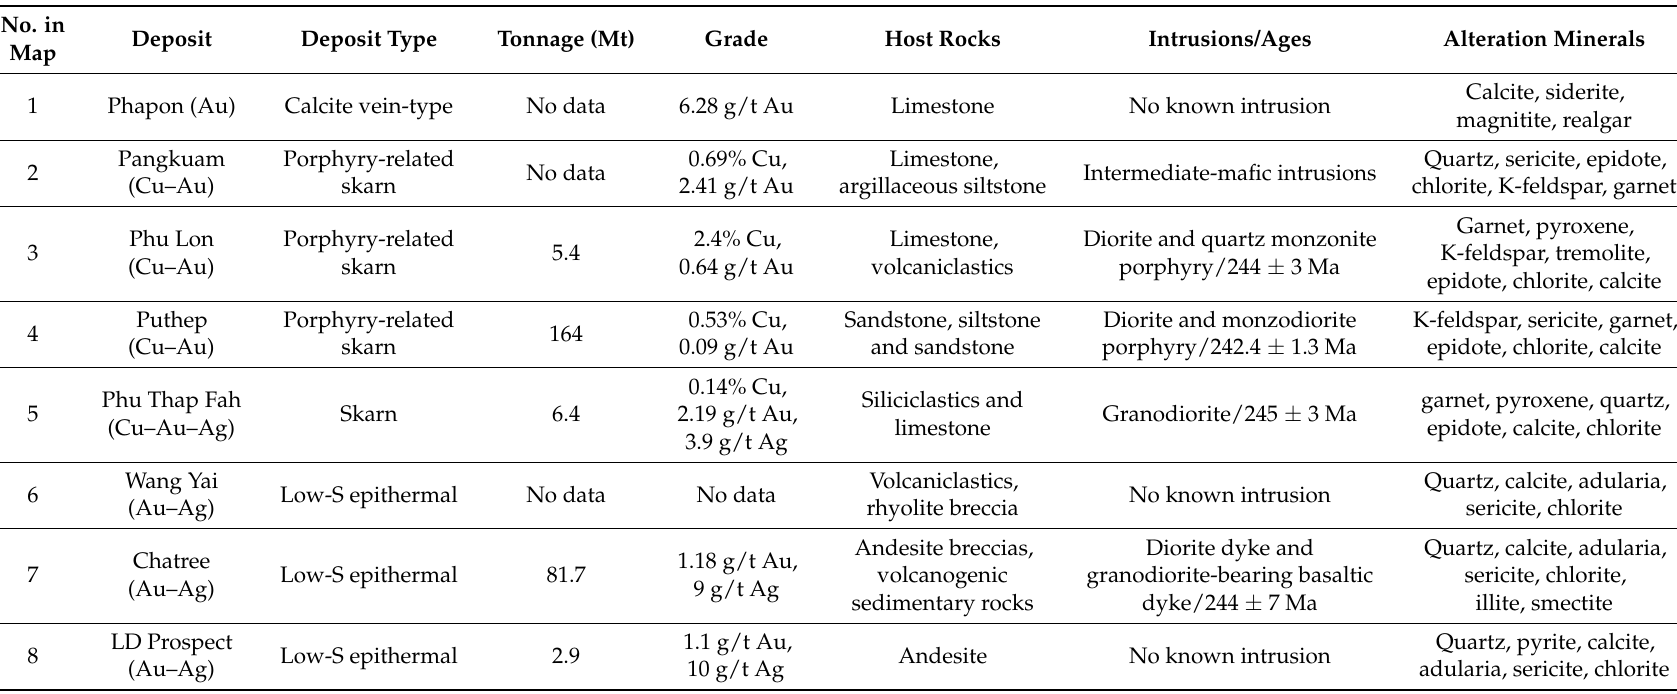
Table 1. Basic information of major gold deposits in the Luang Prabang–Loei metallogenic belt (collated from Zaw et al., 2014; Zhao et al., 2017) [3,44]. No.